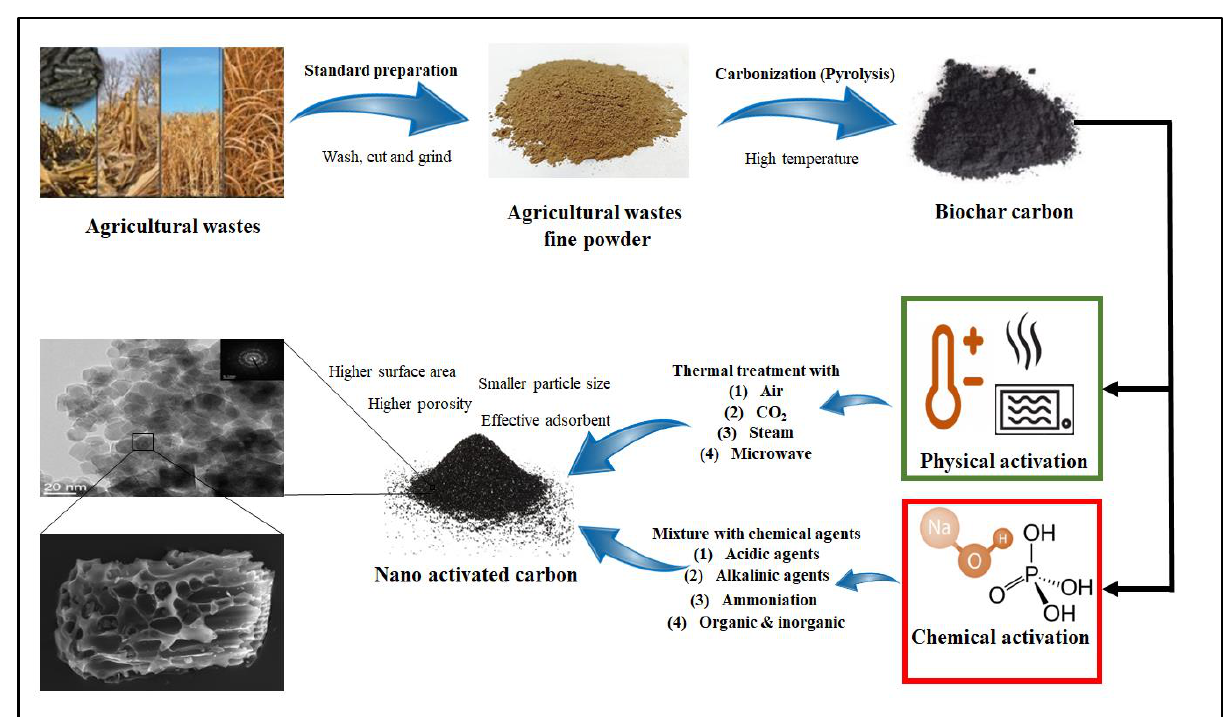
Figure 2. Schematic illustration of agricultural-waste-based nano-activated carbon fabrication.